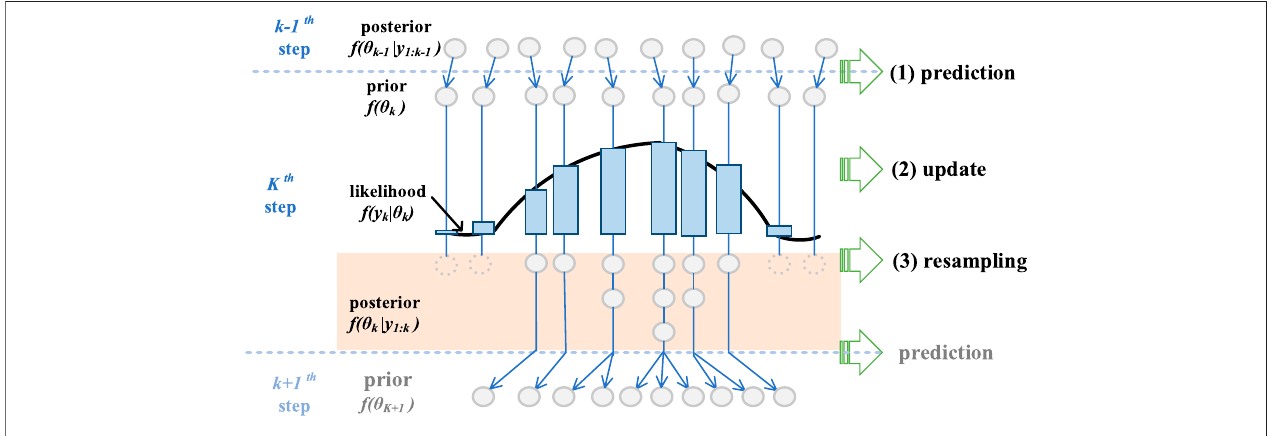
FIGURE 5 | Prediction fl ow chart based on Particle fi lter